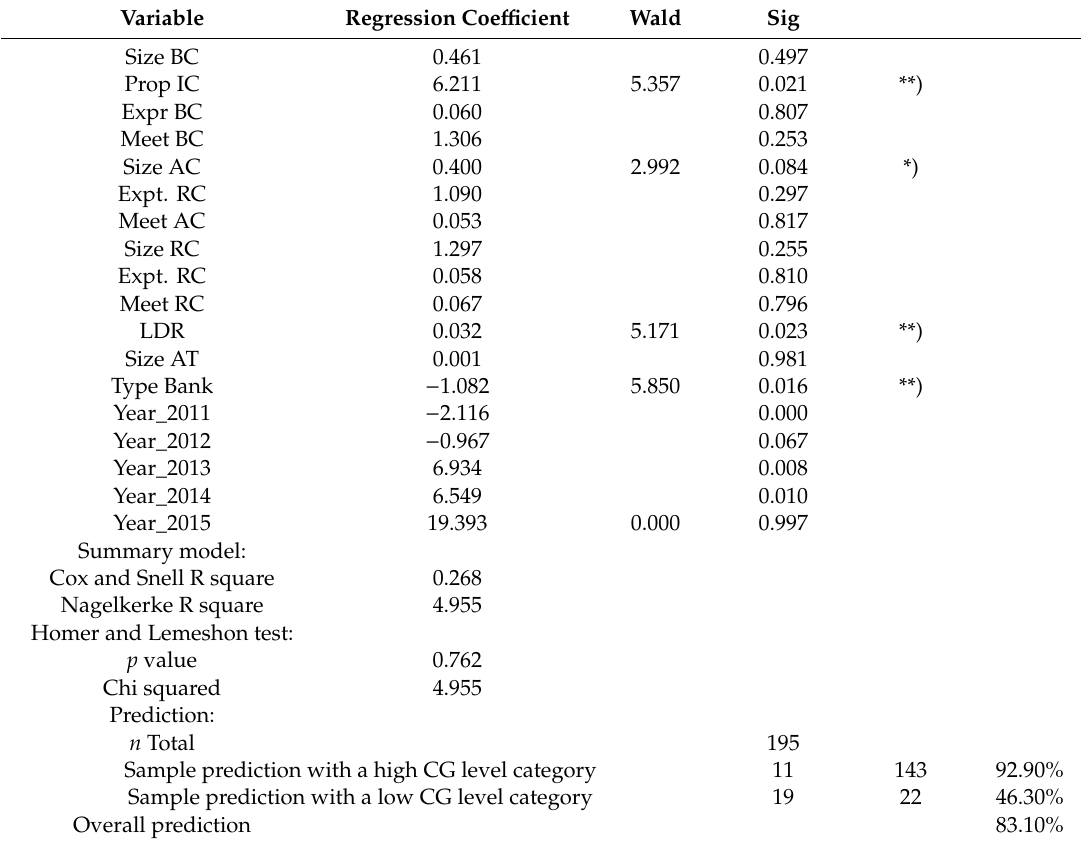
Table 5. E ff ect of board characteristics on level of corporate governance compliance (logistic regression